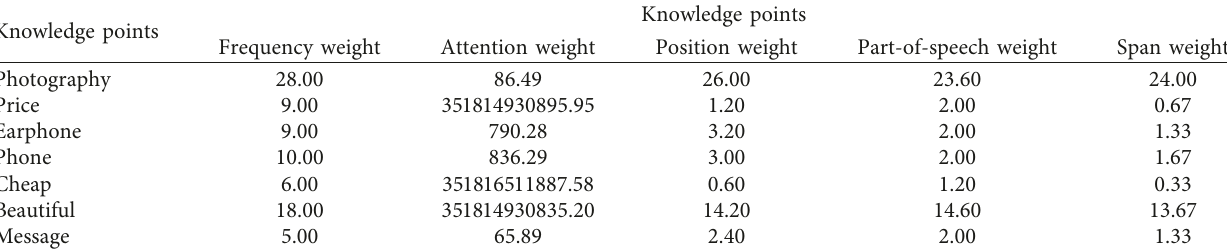
Table 7: Example of the merged knowledge point keywords and their